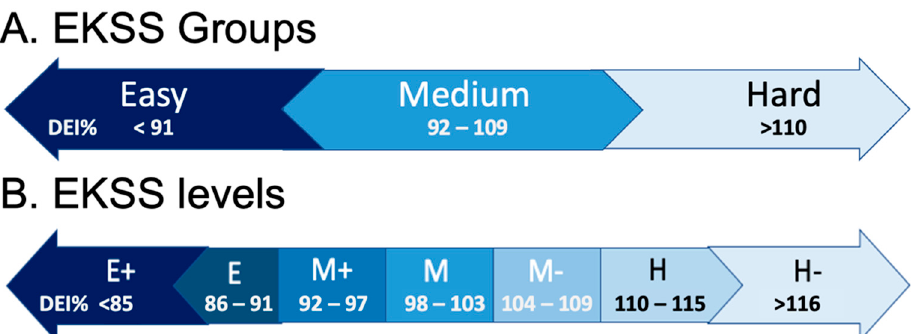
Figure 1. The EKSS offers two identification resolutions, The EKSS groups ( A ) and EKSS levels ( B ). The EKSS groups are offered to agree with the current usage of easy keeper (EK), medium keeper (MK) and hard keeper (HK) terminology but can be further defined to the EKSS level which proposes seven different keeper statuses. RDI 5 % ranges were determined by the recommendations listed by the NRC recommendation that a 10–15% change in DEI can change the BCS score by one point.